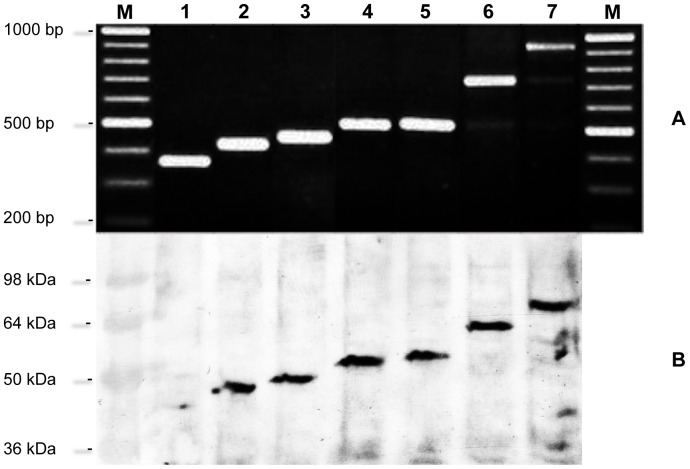
Examination of tolA TR variants by PCR and Western blot.(A) PCR analysis of the TR region of tolA variants. (B) Western blot of membrane proteins of TolA variants with polyclonal antibody against TolA domain III. Size markers in bp (A) or kDa (B) are shown on the left. M: Marker; Lane 1: TolA2TR; Lane 2: TolA6TR; Lane 3: TolA8TR; Lane 4: wild type (TolA13TR); Lane 5: reconstructed wild type (TolA13TR); Lane 6: TolA26TR; Lane 7: TolA39TR.